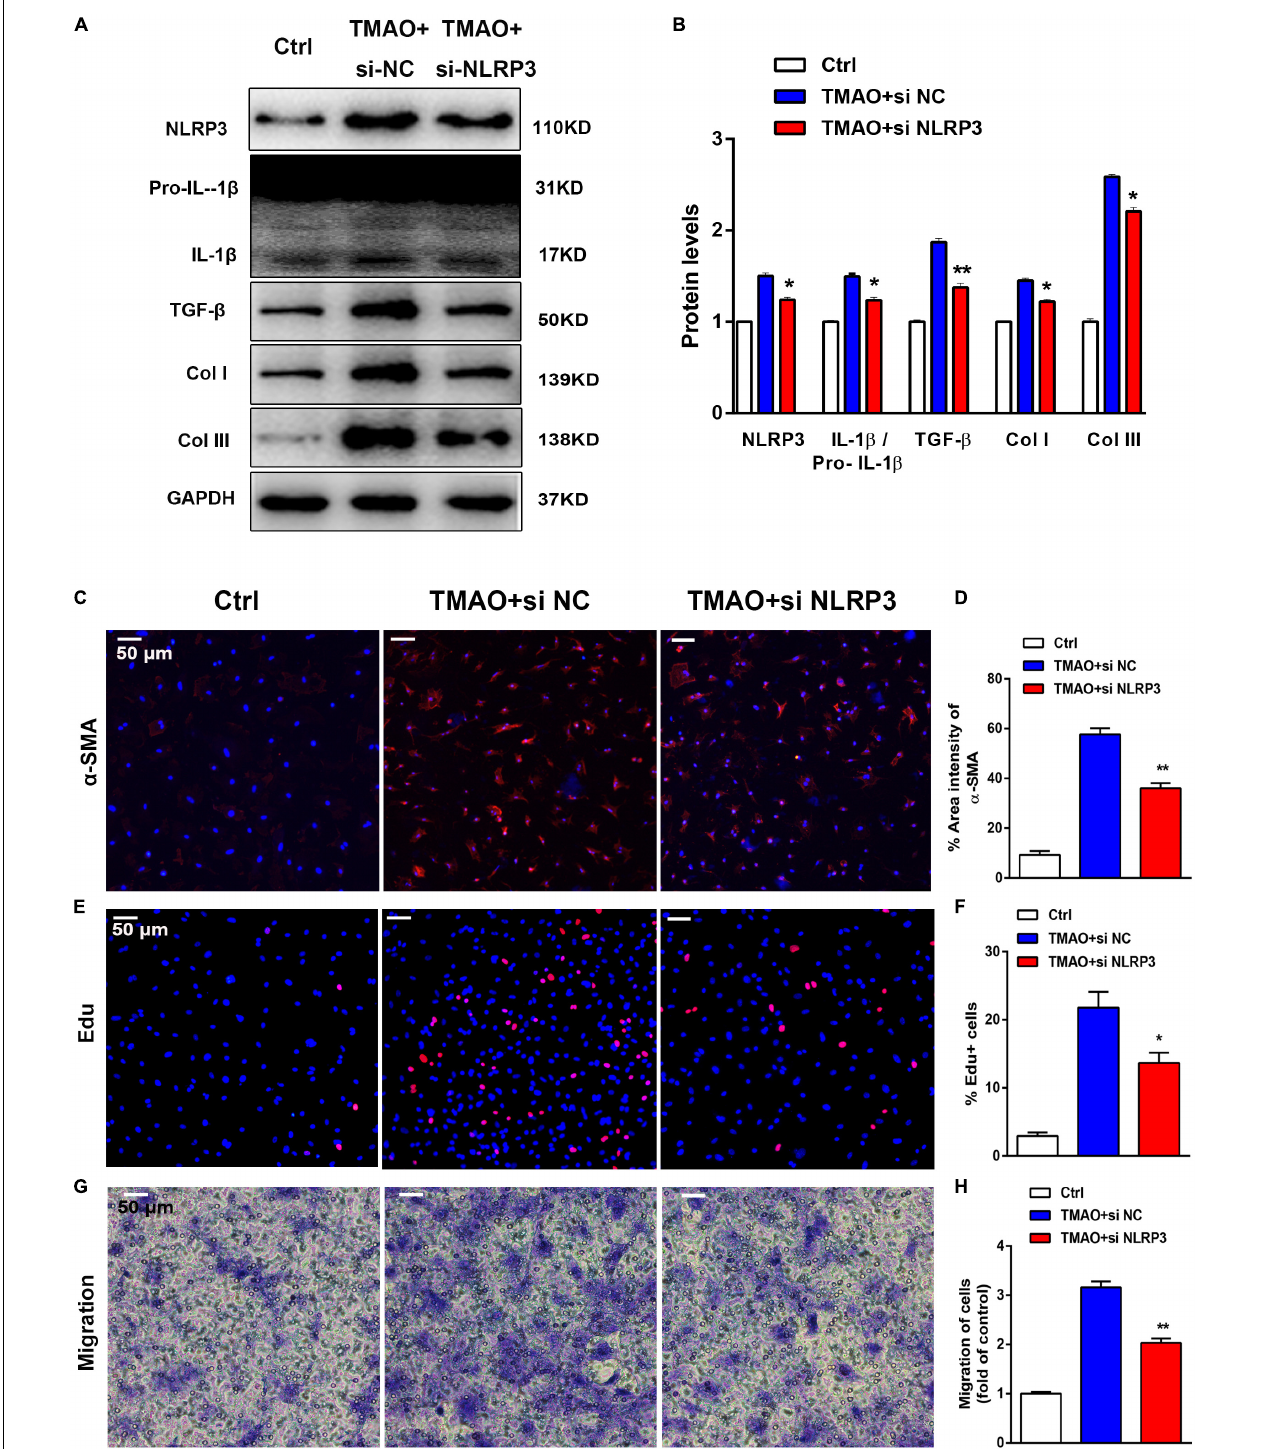
FIGURE 6 | TMAO induced cardiac fibrosis via NLRP3 activation. Knockdown of NLRP3 with siRNA could reverse the effect of TMAO on cardiac fibroblasts. (A) NLRP3, pro-IL-1 β , IL-1 β , TGF- β , Col I and Col III protein expression levels were analyzed by western blotting and quantified (B) according to immunoblotting (the ratio of protein pixel density/GAPDH pixel density). (C) Representative images and quantification (D) of immunofluorescence staining for α -SMA (red) and DAPI (blue) in cardiac sections. (E) Edu staining showing cardiac fibroblast proliferation after 24 h of treatment, and quantification (F) of the percentage of Edu-positive cells (red). (G) Transwell assay showing the stained migrated cardiac fibroblasts after 24 h and calculation (H) . All scale bars = 50 µ m. All data were analyzed at least three times. Mean ± SD. ∗ P < 0.05, ∗∗ P < 0.01, ∗∗∗ P < 0.001 (vs. TMAO + si NC).